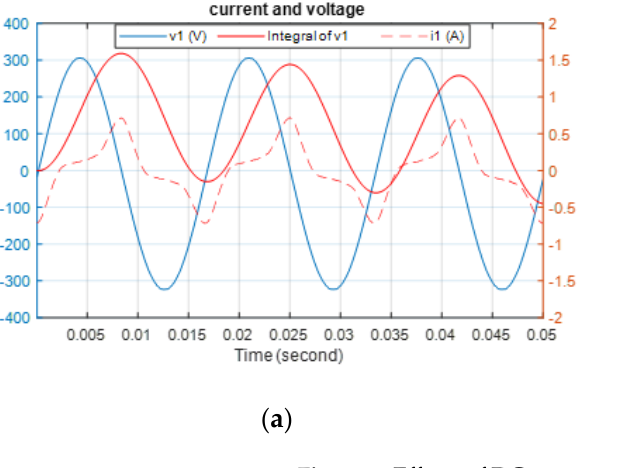
Figure 9. Flowchart of digital integration.